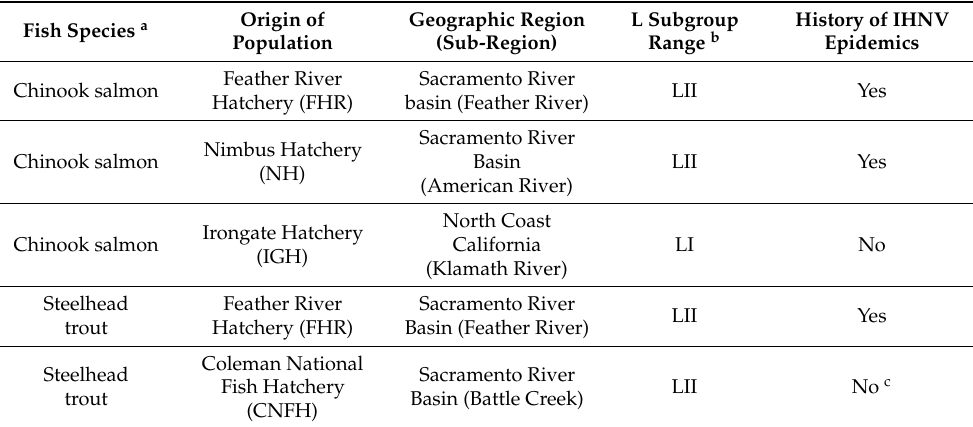
Table 1. California fish populations investigated in virus challenge studies. Fish Species